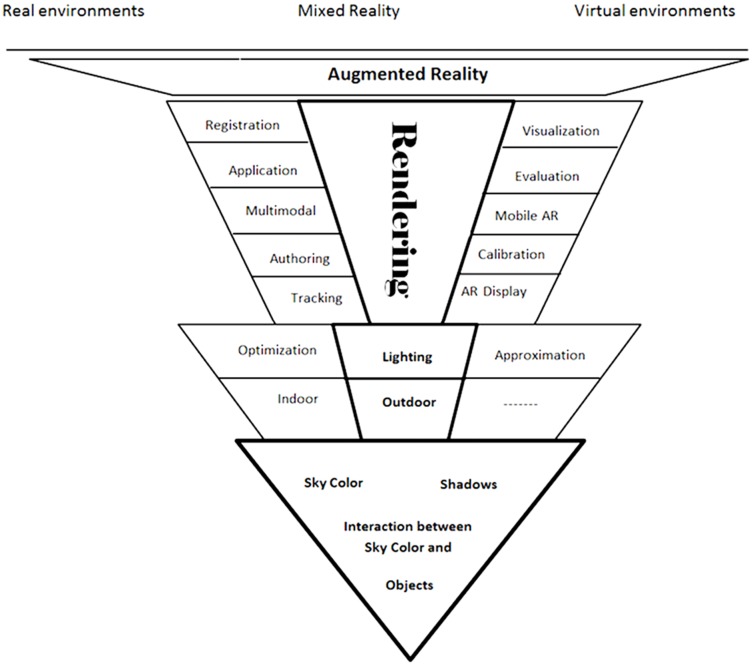
Research focus area.